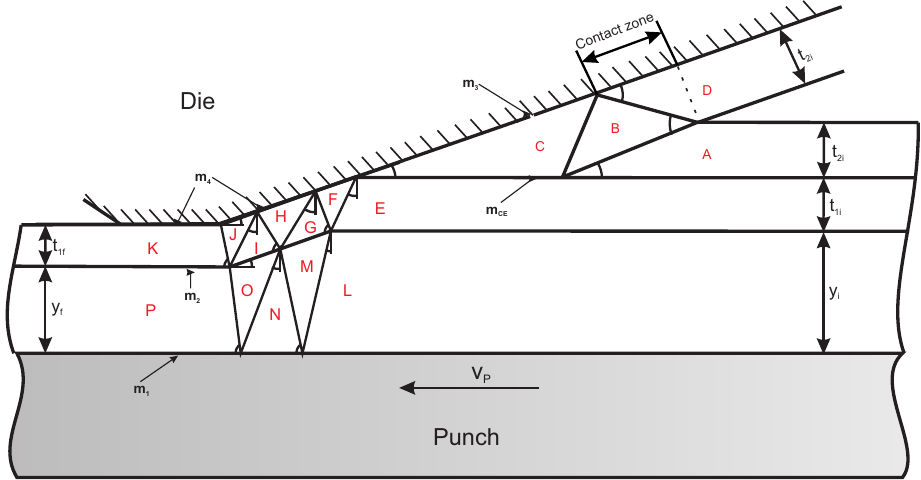
Figure 7. Illustration of the VDF for bad ironing. The layer removed as result of shaving is region D, and its initial and final thicknesses are the same. An estimate was used for the interaction area between the die and this layer because the real area was very complicated to determine. With the approach presented by Wilson [17], the contact length between the die and region D is depicted in Figure